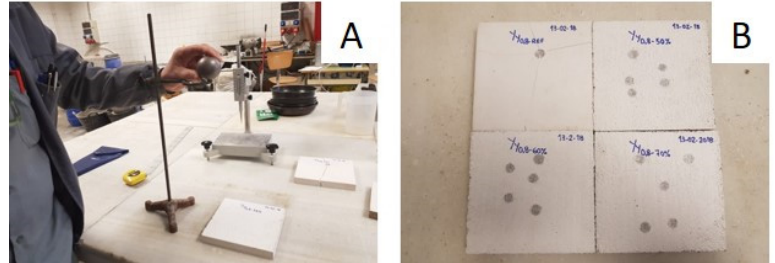
Figure 3. Shock-Impact Resistance test: ( A ) test equipment; and ( B ) board after test.